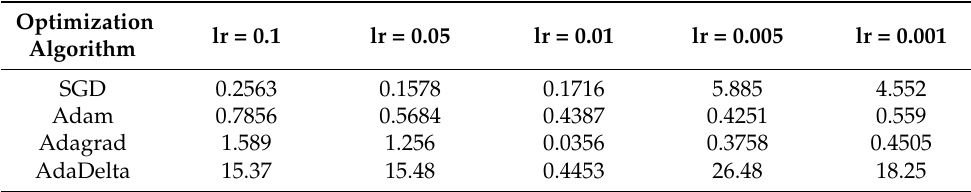
Table 4. Total loss values of RiceDRA-Net on SBG-Dataset under different optimization algorithms and learning rates.